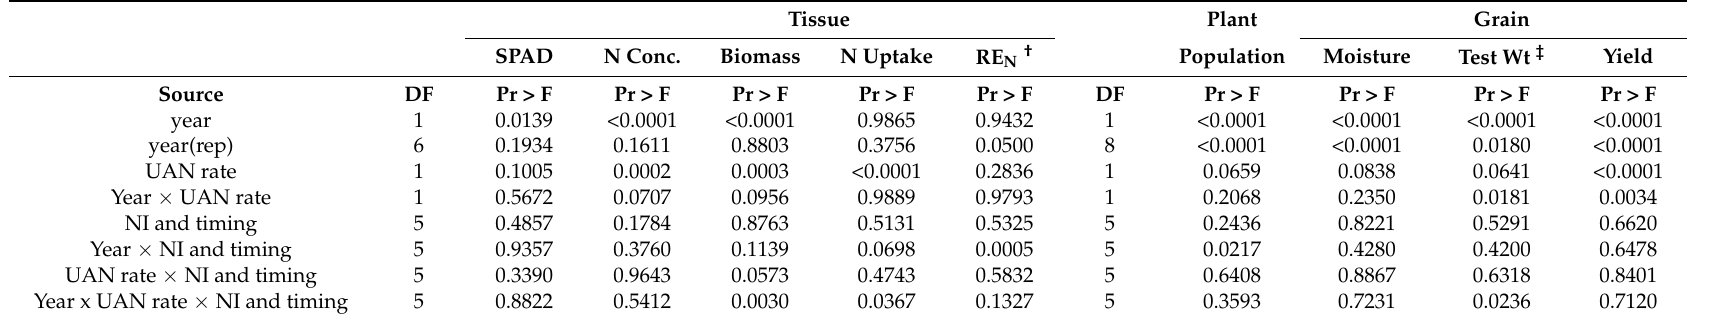
Table 2. Analysis of variance table for plant response in 2015 and 2016 with determined probability values (Pr >